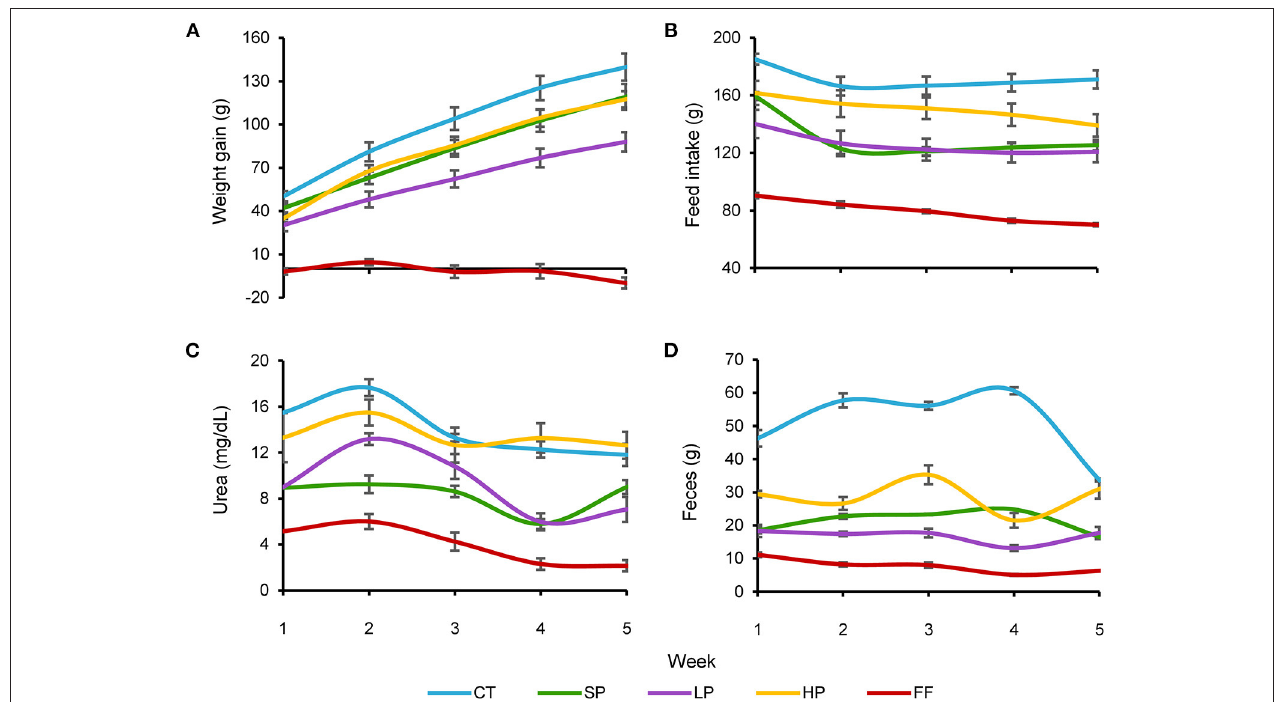
FIGURE 1 | Weekly behavior of different parameters used in each diet: CT, Control; SP, Standard protein; LP, Hypoproteic; HP, Hyperproteic; FF, Hypercaloric. (A) Accumulated weight gain; (B) feed intake; (C) average urea concentration; and (D) feces